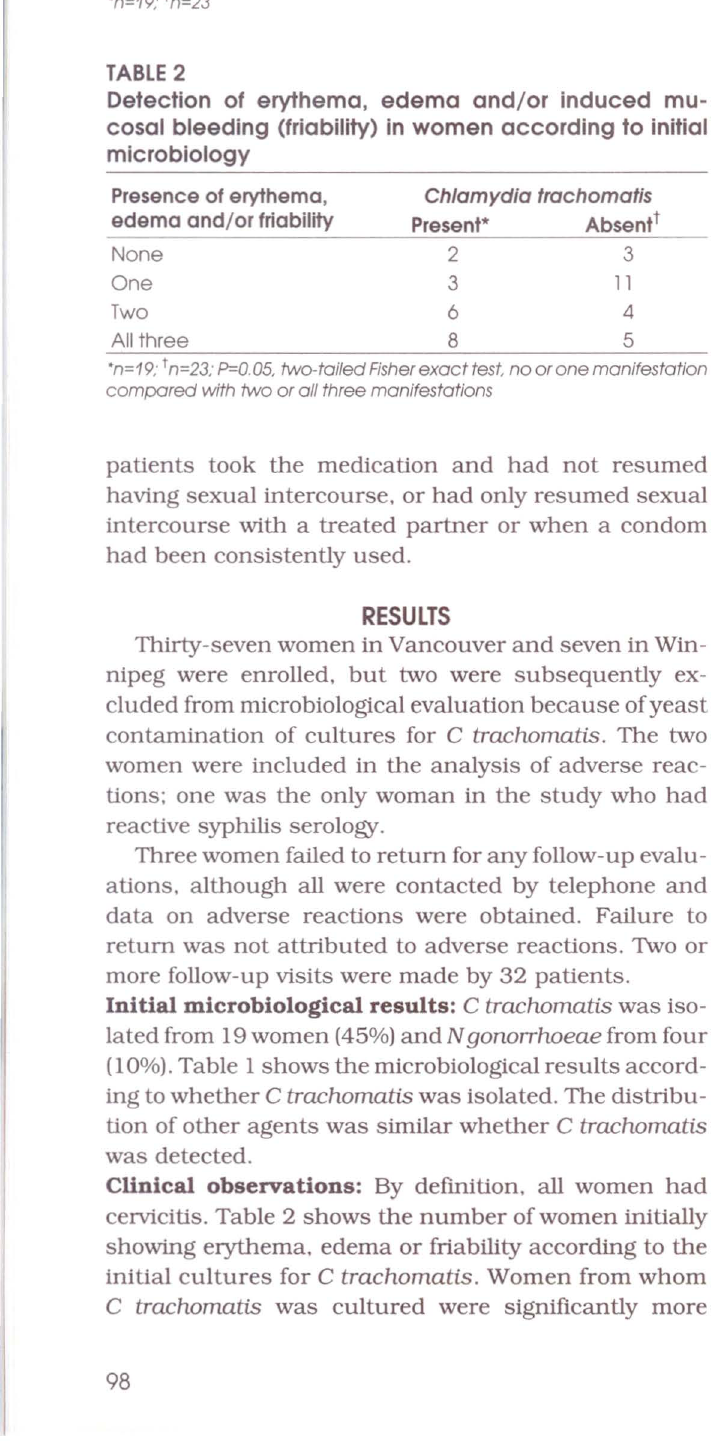
Isolation of genital pathogens at initial visit Chlamydia Neisseria gonorrhoeae Ureaplasma urealyticum Large colony mycoplasmas